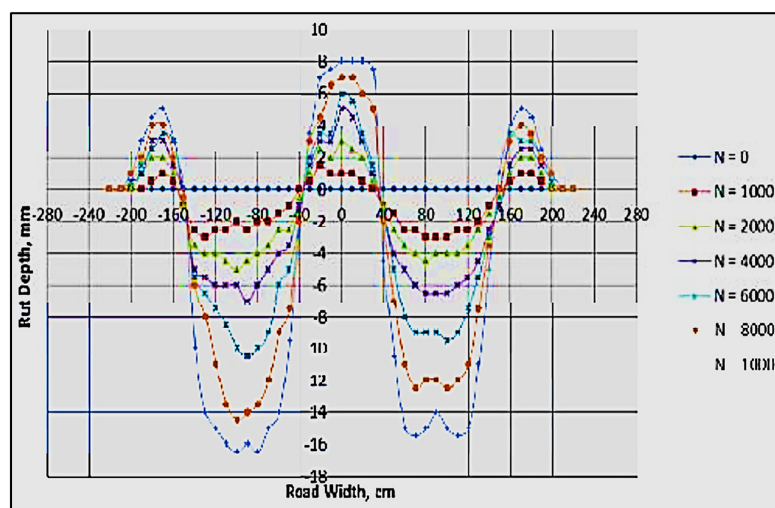
Figure 14: Rutting depth at interface III.